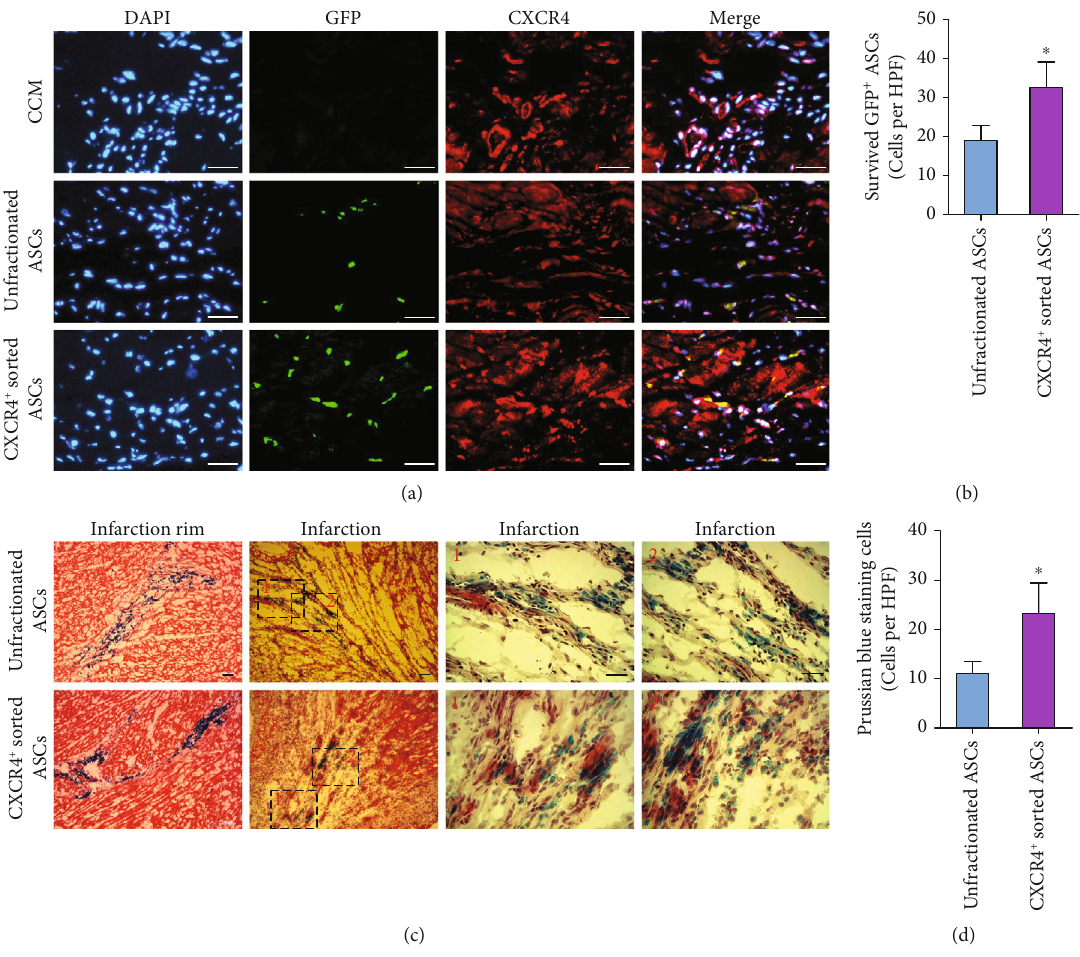
Figure 5: CXCR4 + sorted ASCs exhibited more robust engraftment into infracted myocardium than did unfractionated ASCs in vivo. (a) CXCR4 + and GFP + ASCs were detected at 4 weeks posttransplantation in CXCR4 + sorted ASC-treated rats. (b) CXCR4 + sorted ASCs showed much higher engraftment than unfractionated ASCs. (c) SPIO-labeled ASCs were transplanted into viable myocardium bordering infarct zone and engrafted into infarcted myocardium with duration of recovery. (d) More cells containing blue-stained particles were detected in CXCR4 + sorted ASC-treated rats than in unfractionated ASC-treated rats. Scale bar represents 50 μ m. ∗ p < : 05 versus unfractionated ASCs. Abbreviations: CXCR4: CXC-chemokine receptor 4; ASCs: adipose-derived stem cells; GFP: green fl uorescent protein; DAPI: 4 ′